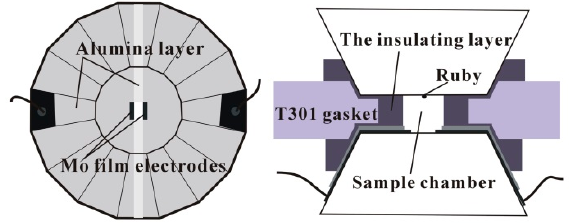
Figure 1. The completed microcircuit ( left ) on diamond anvil and the profile of our designed diamond anvil cell (DAC) ( right ).